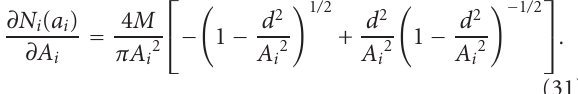
The derivatives ∂σ/∂A i ≤ 0 represent amplitude A i of a parts ( σ ) of characteristic roots of (27) become positive.